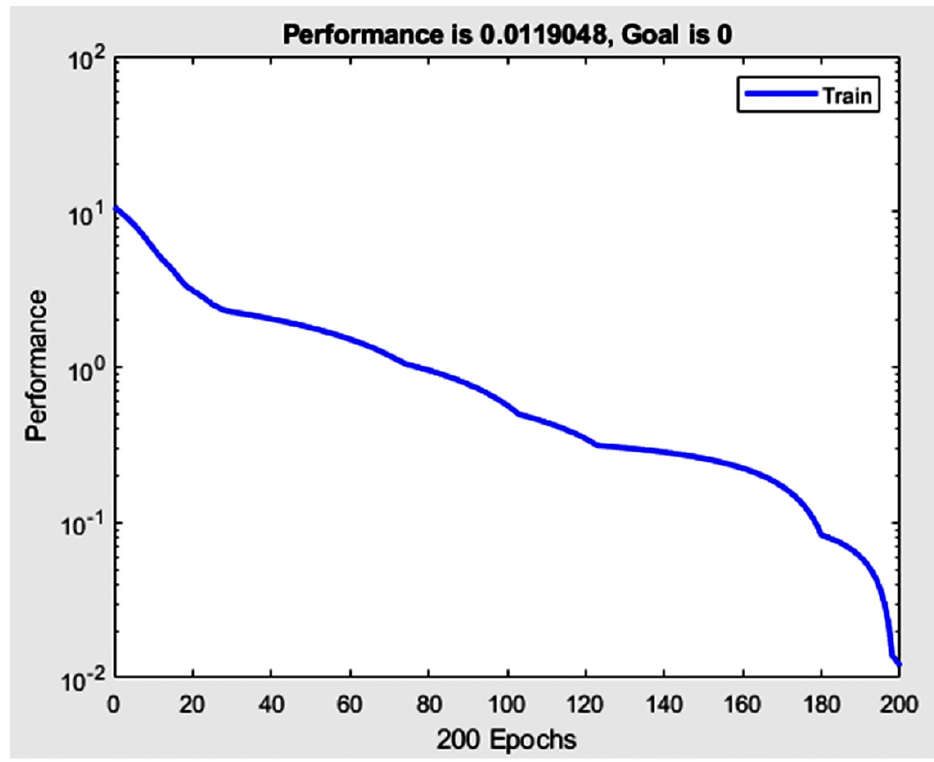
Figure 10. Performance of training for Duval_Pentagon_1_RBFNN.